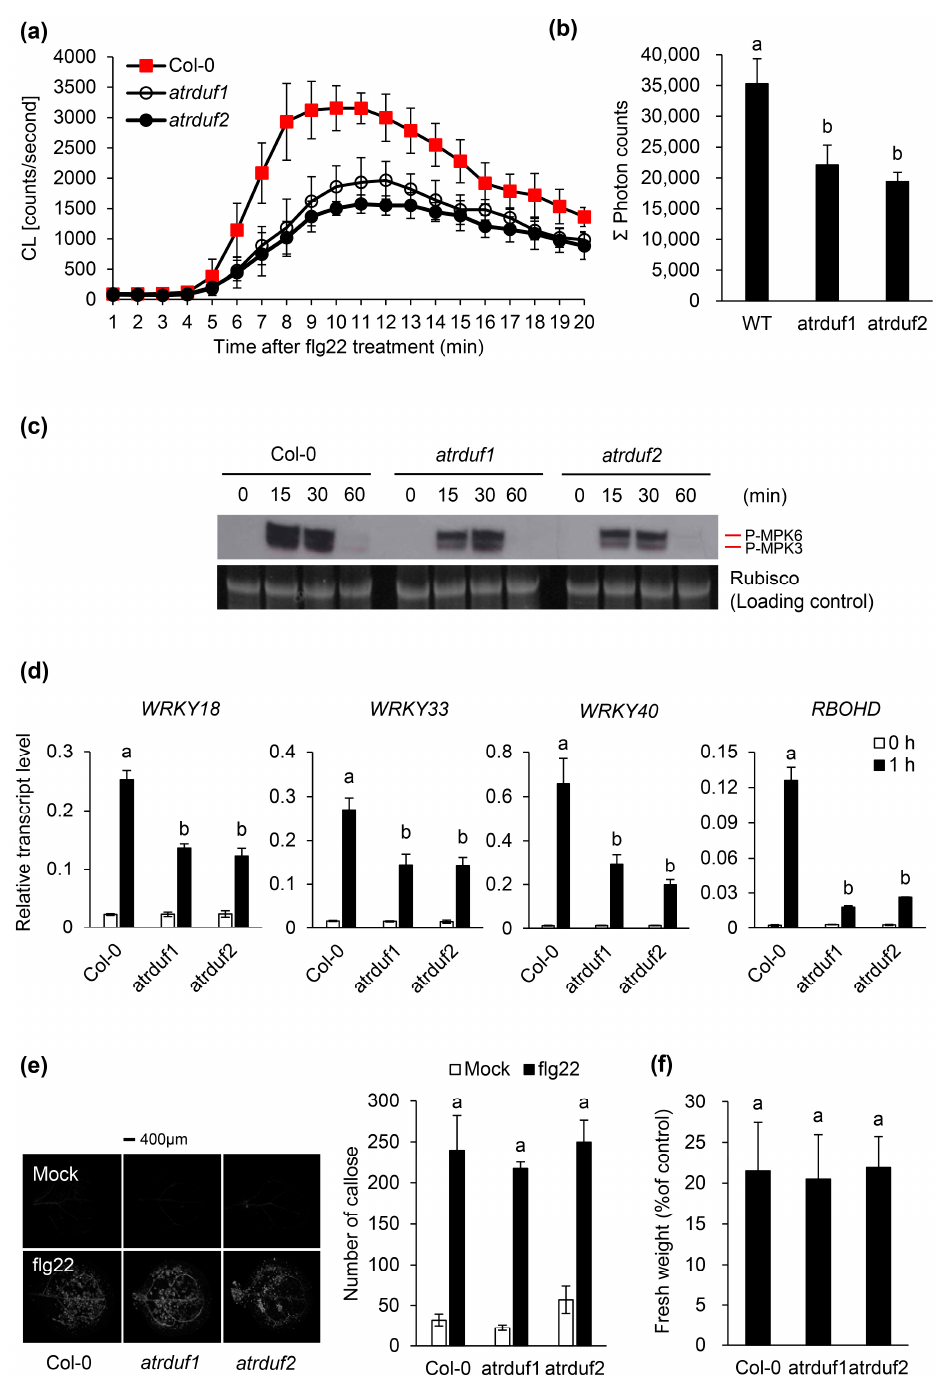
Figure 2. Functions of AtRDUF1 and AtRDUF2 during flg22-triggered immune signaling. ( a ) Flg22-induced reactive oxygen species (ROS) generation in liquid-grown intact seedlings of indicated Arabidopsis genotypes after treatment with 1 µ M flg22. Error bars represent standard deviations of eight independent samples. Similar results were obtained in two independent experiments. ( b ) Flg22-induced ROS production in the indicated genotypes is represented as the integrated area under the ROS curve measured during a time course of 20 min and is referred to as Σ photon counts. Values are the mean ± SD ( n = 8). ( c ) Dual phosphorylation of TEY motif in MPK3 and MPK6 in 8-day-old seedlings. Phosphorylated mitogen-activated protein kinases (MAPKs) corresponding to MPK3 and MPK6 are indicated. Activated MAPKs were detected by immunoblotting using anti- body against Phospho-p44/42 MAPK (Erk1/2) (Cell Signaling Technology). The experiment was per- formed three times with similar results. Prior to transfer to polyvinylidene difluoride (PVDF) mem- brane, equal protein loading was checked by comparing the fluorescence intensity of Rubisco in